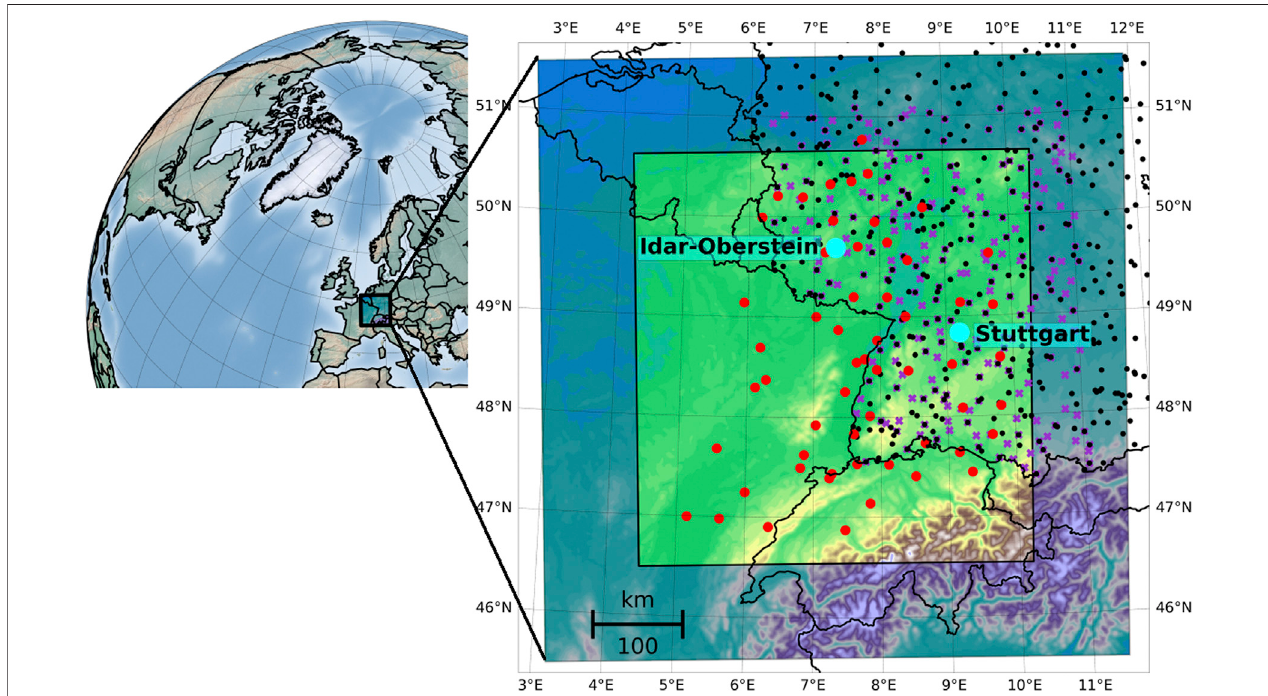
FIGURE 1 | Overview of the WRF domain with evaluation area (bright area), synoptic stations (black dots), additional precipitation stations (purple crosses), GNSS stations (red dots) and radiosonde stations (blue dots).